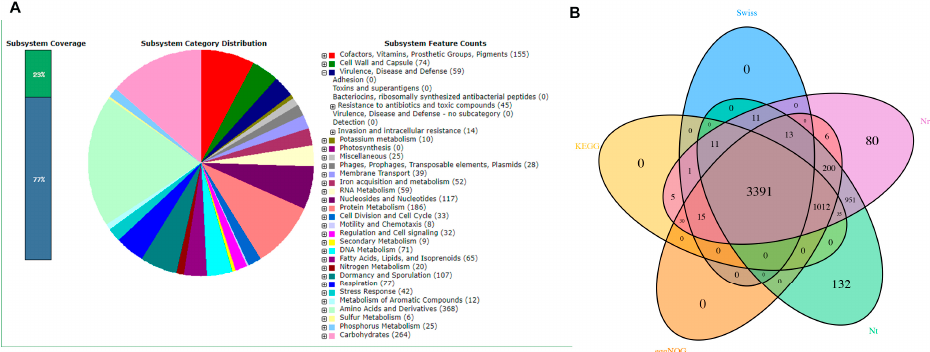
Figure 2. De novo sequencing results of the strong virulence of B. cereus (BC1908). ( A ) RAST analysis of BC1908 for virulence and resistance genes. ( B ) The intersection of analysis between different platforms (KEGG, eggNOG, Nt, Nr, and